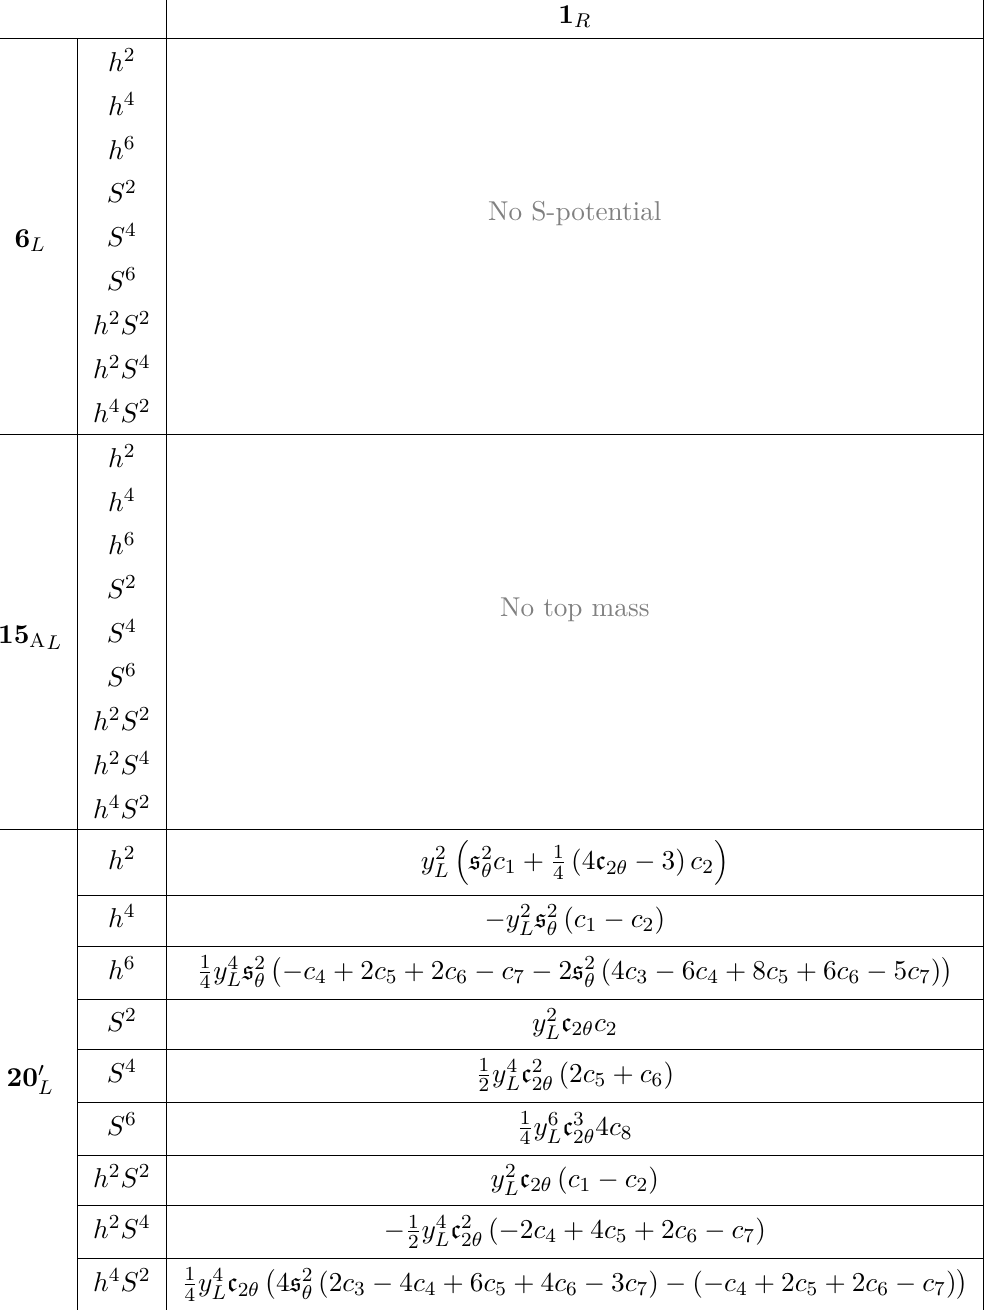
Table 1 . V ( h, S ) terms obtained via spurion analysis for t R a SO(6) singlet. Only leading terms are shown and each entry should be multiplied by N c m 4 a factor 1 /f and every y L,R with a 1 /g ∗ . The coefficients c i of the various invariants are just numbered consecutively. Parameters that contribute in the same way in the given approximation were collected into single c i and we abbreviate c 2 θ = cos 2 θ 20L , s 2